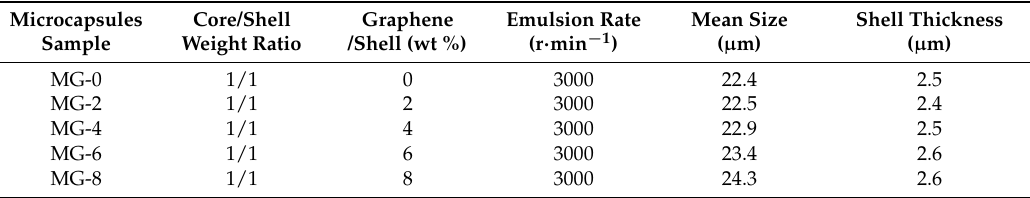
Table 1. Characters of microcapsules with various graphene contents in